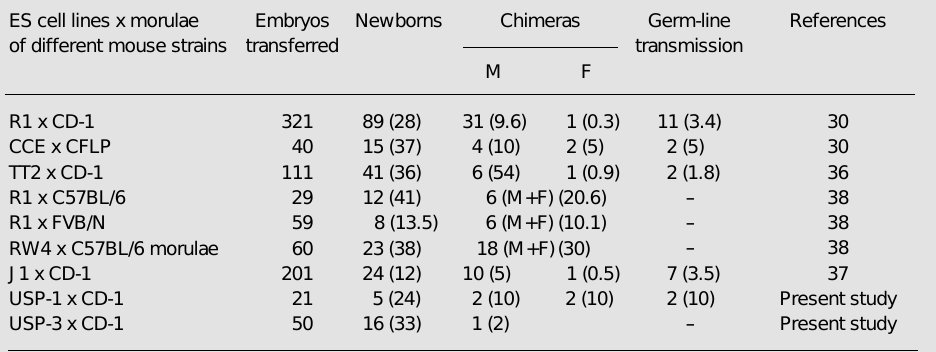
Table 2. Results of aggregation of several embryonic stem (ES) cell lines with morulae from different mouse strains obtained in independent experiments. ES cell lines x